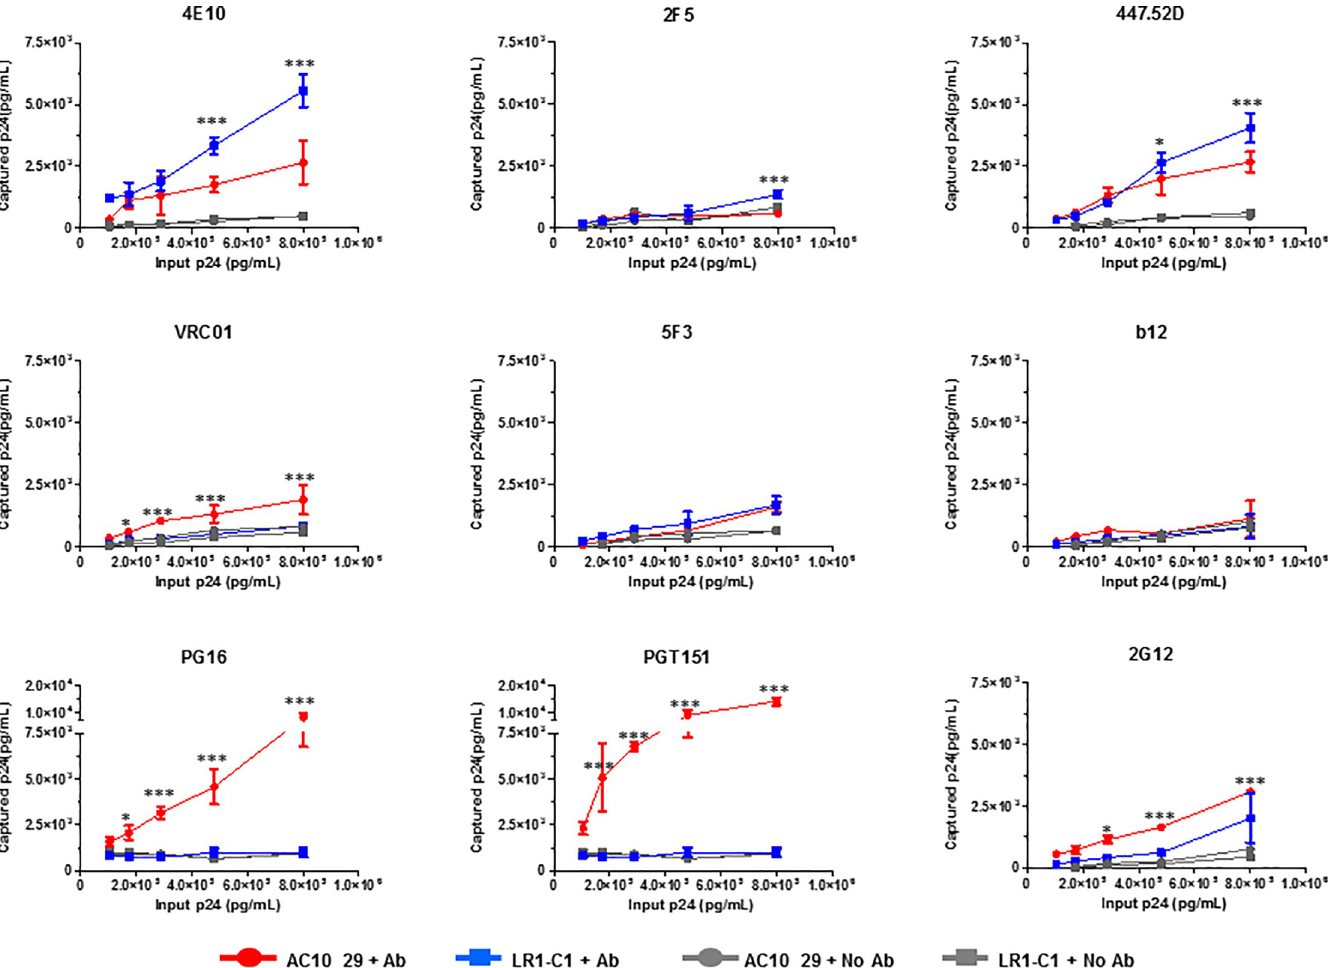
Fig 3. Effect of LR1-C1 mutations on affinity for selected bNAbs. Virus stocks were obtained from transfected 293T cells. Increase in Ab binding was determined by comparison of the virus captured by different monoclonal antibodies and quantified by p24 when similar amounts of virus (AC10_29 in red and filled circles and LR1-C1 in blue and filled squares) were used as input in a Virion Capture Assay (VCA) with the Abs 4E10 (MPER), 2F5 (MPER), 447-52D (V3), VRC01 (CD4bs), 2G12 (N332 V3 glycan patch), b12 (CD4bs), PG16 (quaternary; V1-V1 glycan apex), PGT151 (quaternary; gp120-gp41 integrase) and 5F3 (gp41). Similar amounts of virus suspension with no mAb were used as controls for both viruses (AC10_29 in grey and filled circles and LR1-C1 in grey and filled squares). Statistical analysis was conducted by R using One-way NOVA followed by Newman Keuls post hoc test at each input concentration ( ��� p < 0.001 and � p < 0.05). Data are represented as mean ±